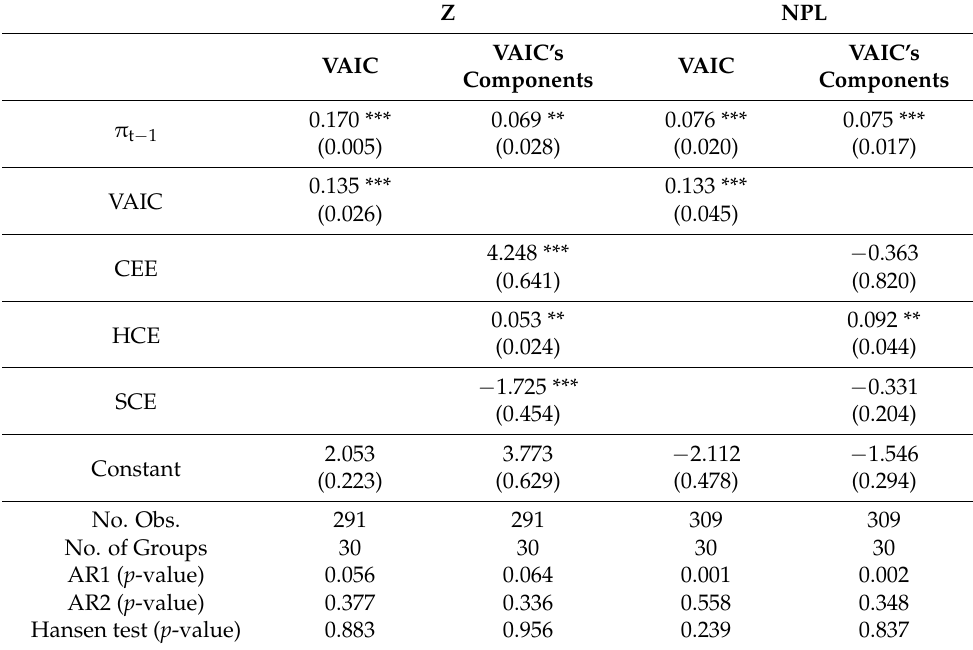
Table 10. VAIC, VAIC’s components and Z, using system